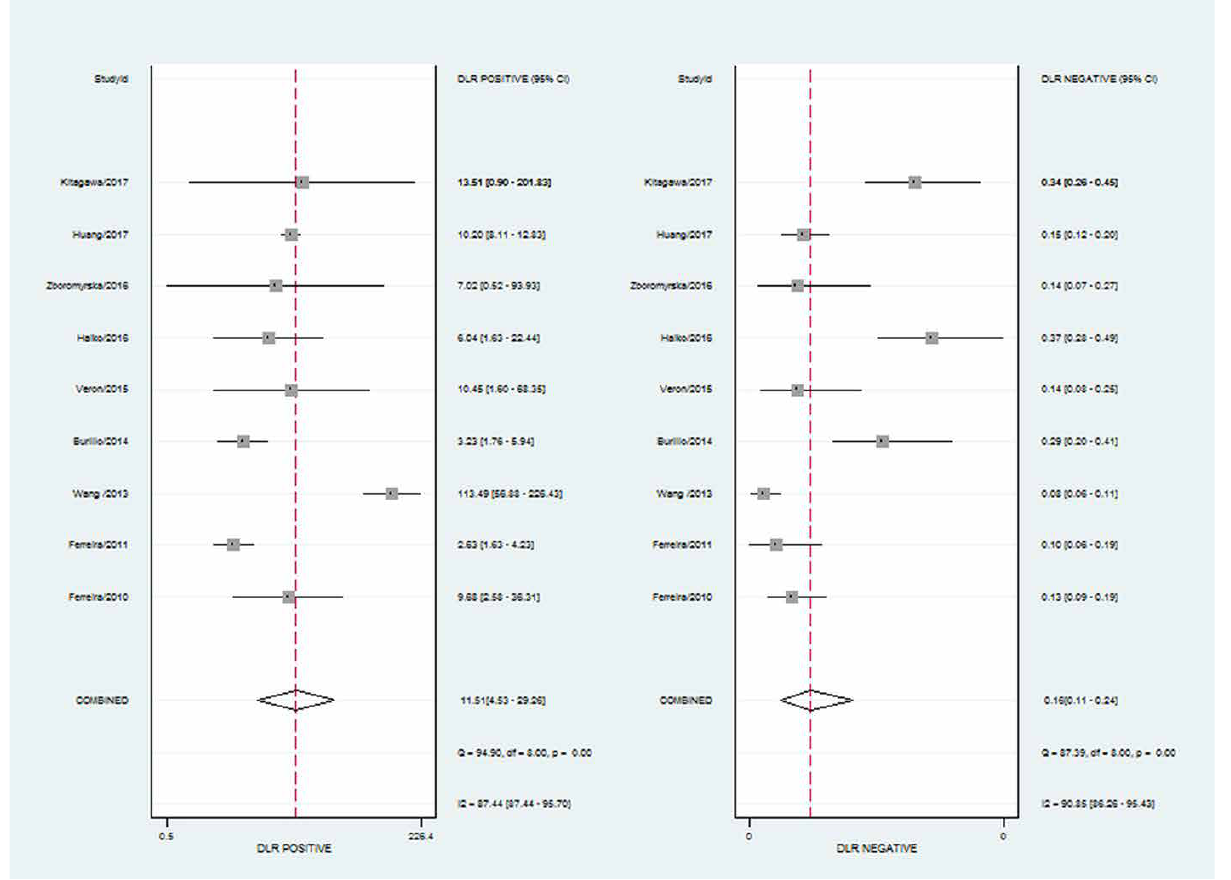
Figure 3: Forest plot of positive likelihood ratio and negative likelihood ratio.